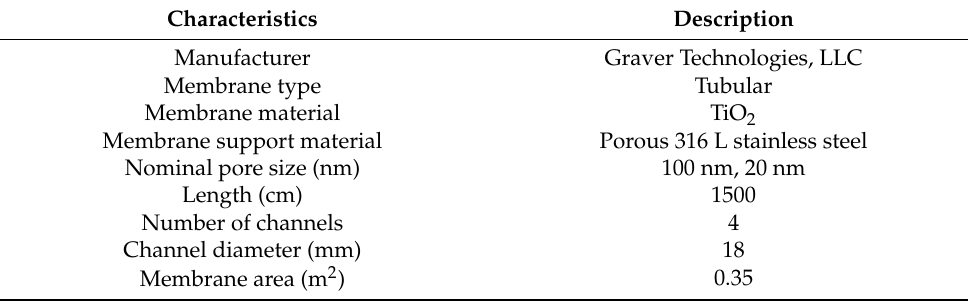
Table 2. Characteristics of membranes.